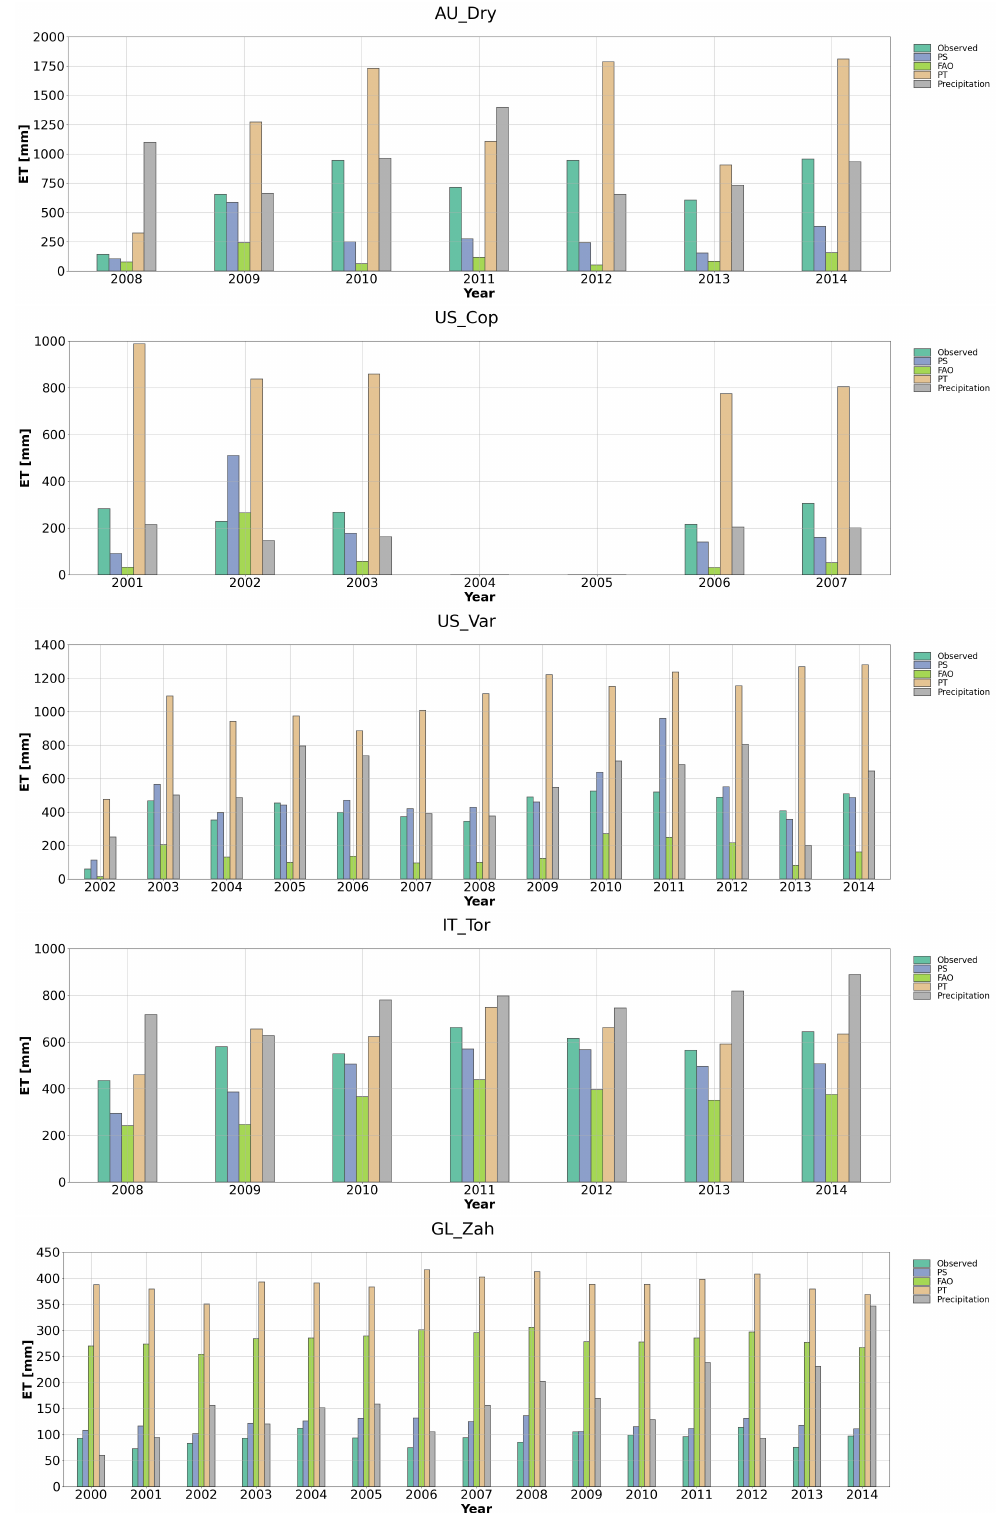
Figure 4. Annual cumulated volumes of ET, modelled (PS, FAO and PT) and measured and annual cumulated precipitation, for each investigated